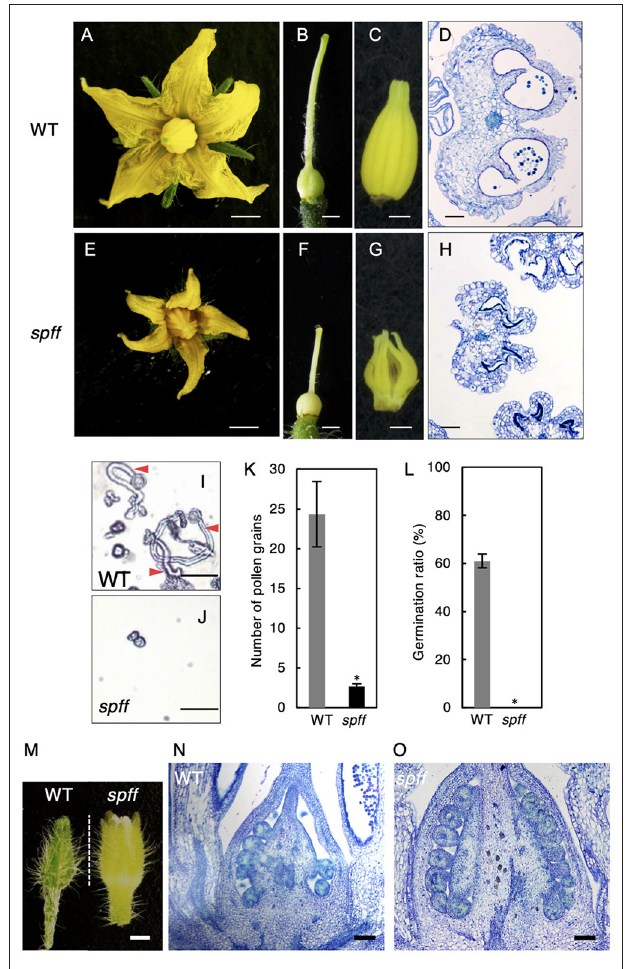
FIGURE 4 | Reproductive organ phenotypes in the spff mutant. Morphology of flower (A,E) , pistil (B,F) , and anthers (C,G) in WT (A-C) and spff (E-G) at anthesis. Histological sections of WT (D) and spff (H) anthers at the anthesis stage. (I) Pollen tube elongation from WT pollen. Red arrowheads indicate pollen tubes. (J) Pollen grains from the spff mutant, without elongation of pollen tubes. (K) Number of pollen grains in a microscopic field. (L) Germination ratio of pollen tubes. (M) Appearance of floral bud length of 4mm. Longitudinal section of ovaries from 4mm floral buds (M) in WT (N) and spff (O) . Bars are 2mm (A,E) ; 1mm (B,C,F,G) ; 100 µ m (D,H,N,O) , and 50 µ m (I,J) . At least three biological repetitions were performed and their mean values with SE are shown. Asterisks indicate significant difference between WT and spff mutant (Student t- test, p < 0.01).